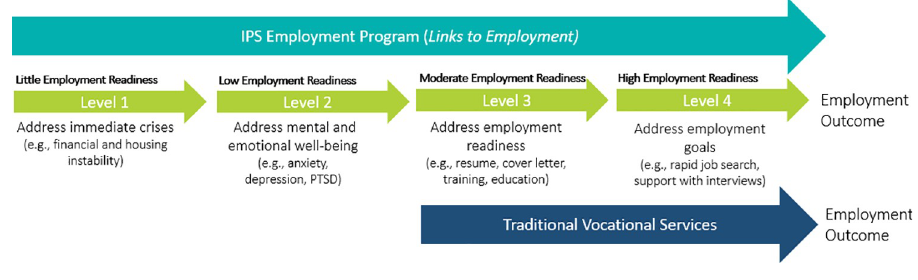
Fig 1. Intervention